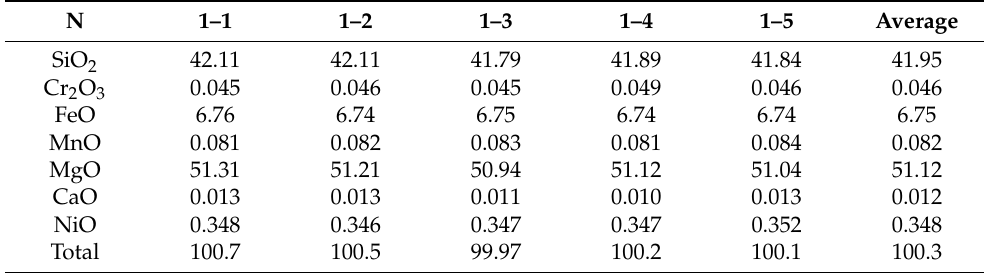
Table 1. Composition of the host olivine